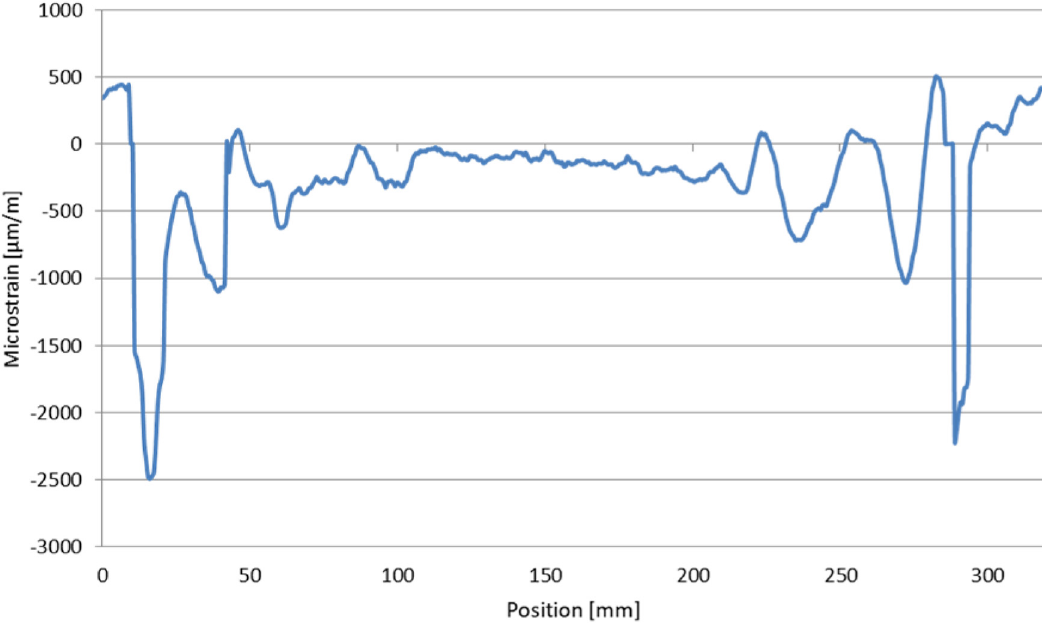
Fig. 2. Deformation after curing of the fi xed bearing specimen.